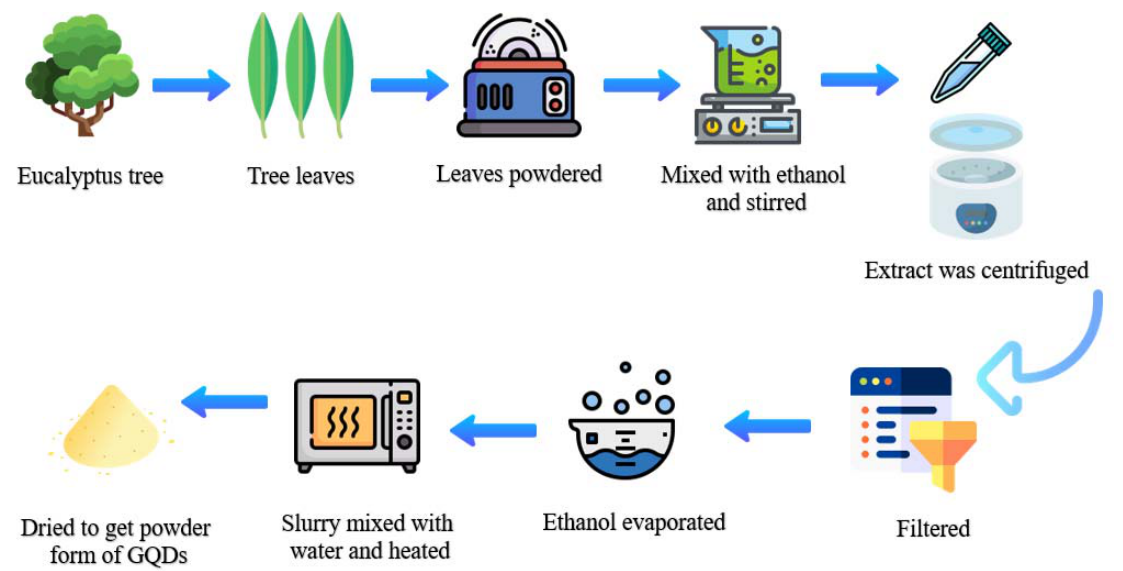
Figure 1. Graphical diagram for the preparation of GQDs from Eucalyptus tree leaves.